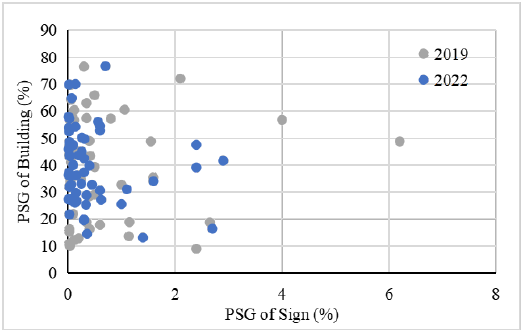
Figure 7. PSG of building-to-sign ratio for selected points before and after the pandemic.